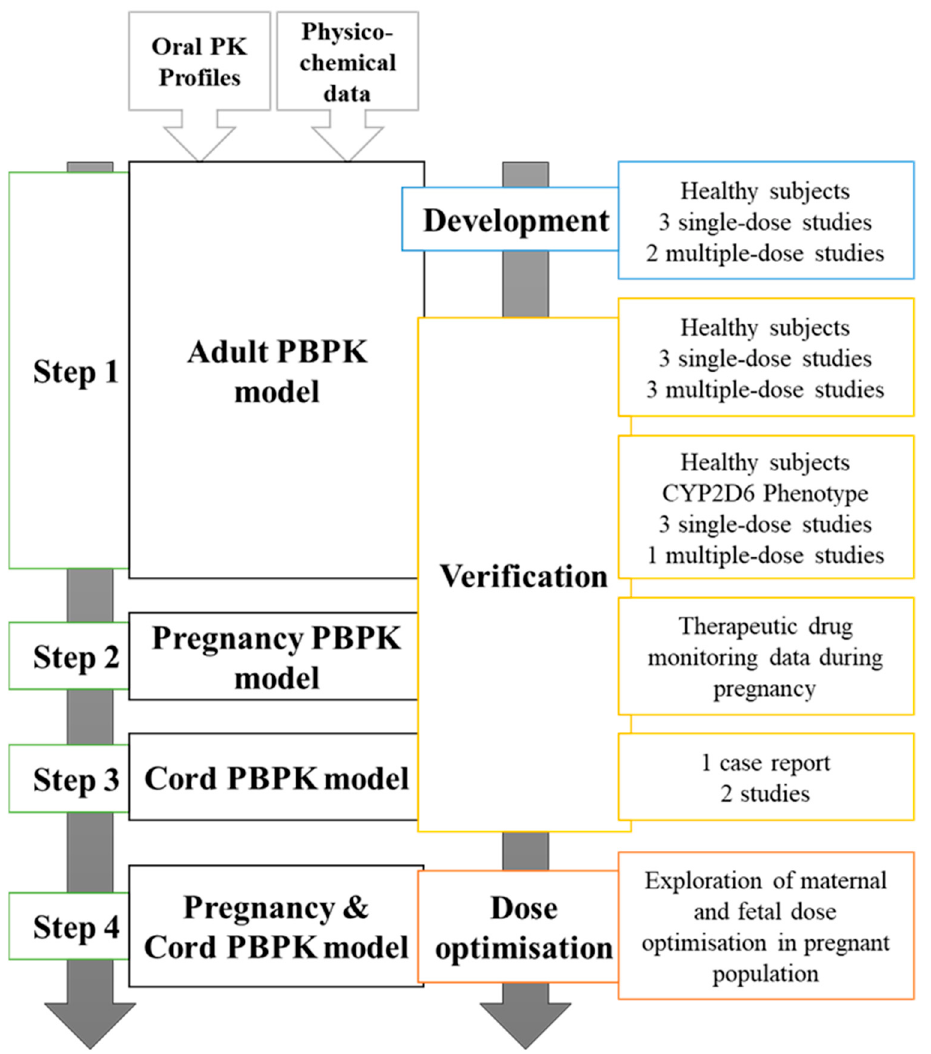
Figure 1. A 4-step workflow for fluvoxamine gestational model’s development.